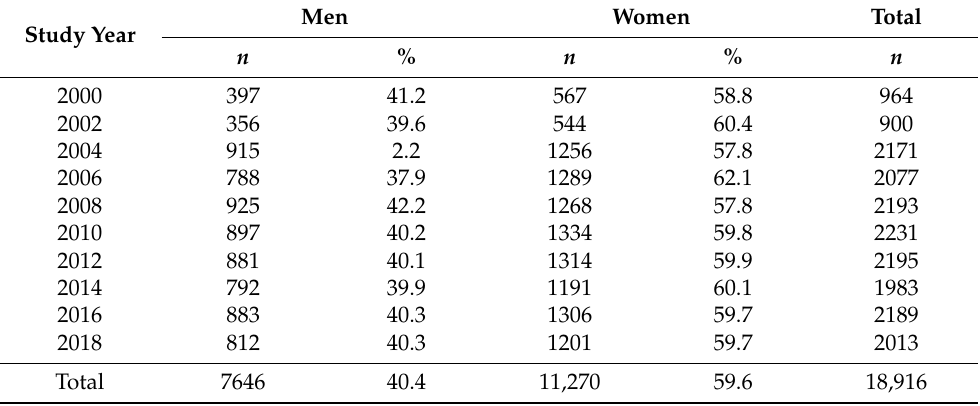
Table 1. Study sample of 25–64-year-old men and women by study year in Estonia, 2000–2018. Men Study Year